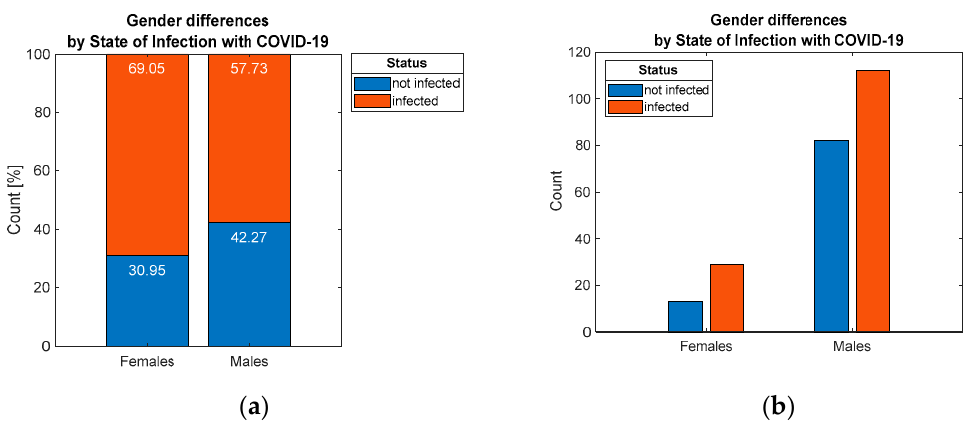
Figure 5. Distribution of respondents by: ( a ) percentage and ( b ) count, considering differentiation by gender.